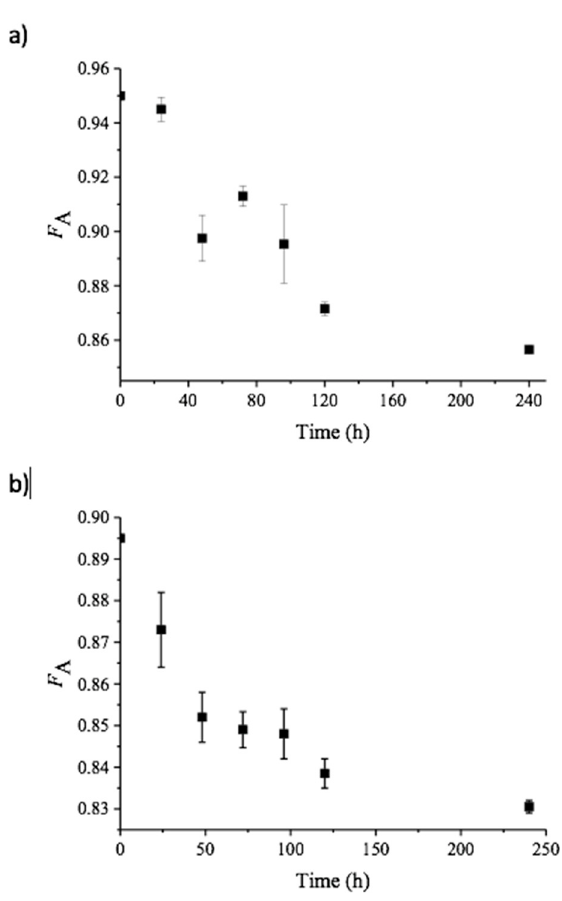
Figure 2. Change in F A over time upon incubation of α -chitin ( a ) or β -chitin ( b ) with Vc CDA at pH 8.0 and t = 37 °C, as determined by 1 H NMR spectroscopy. The points show average values derived from three independent experiments with standard deviations. Note that starting F A values were 0.950 and 0.895 for α - and β -chitin, respectively.